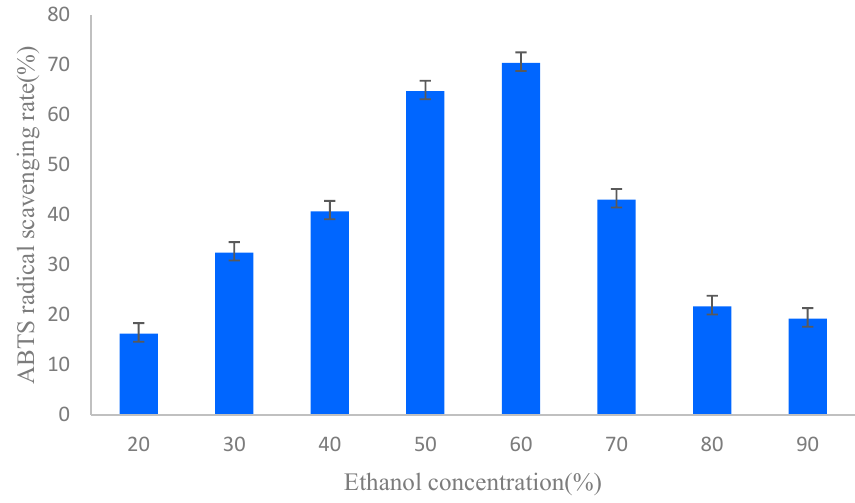
Figure 1. ABTS free radical scavenging rates of different ethanol concentration elution fractions.